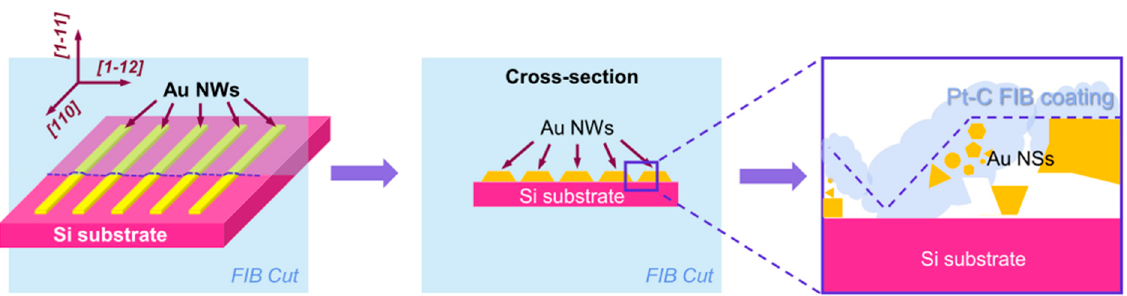
Figure 7. Scheme of the sample preparation for TEM analysis via FIB cut. The sample was studied along the Si (substrate) (110) zone axis. A layer of Pt is deposited on the top of the sample with an ion beam to protect the structures from the destructive cutting procedure.